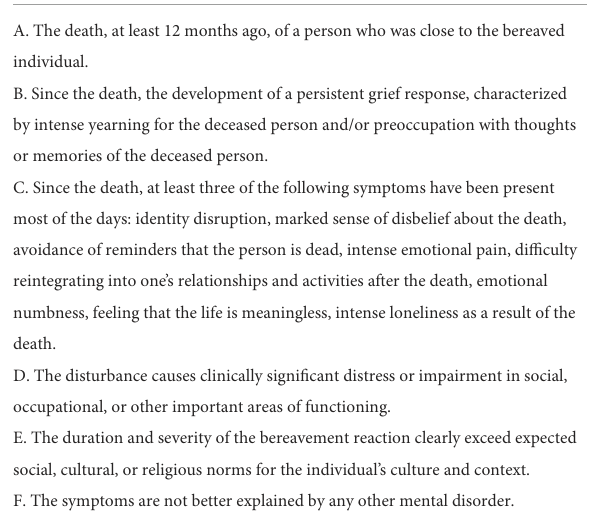
TABLE 1 Summary of diagnostic criteria of prolonged grief disorder